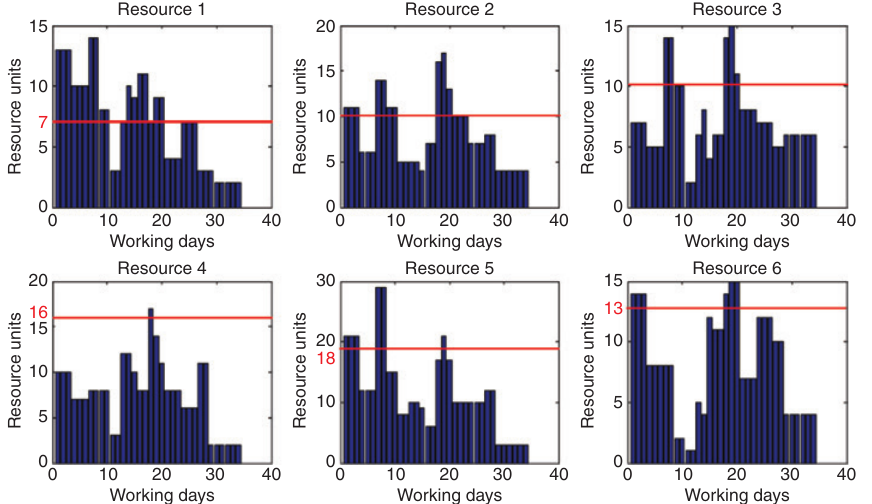
Figure 9: Resource Utilization in Project